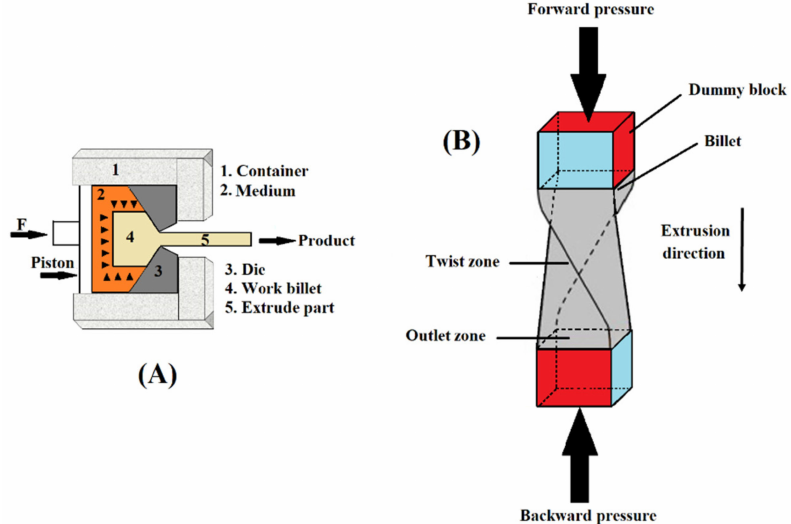
Figure 4. Schematic of a hydrostatic extrusion (HE) device ( A ); reproduced from [47] with permission from Elsevier, 2020. Schematic of the twist extrusion (TE) process ( B